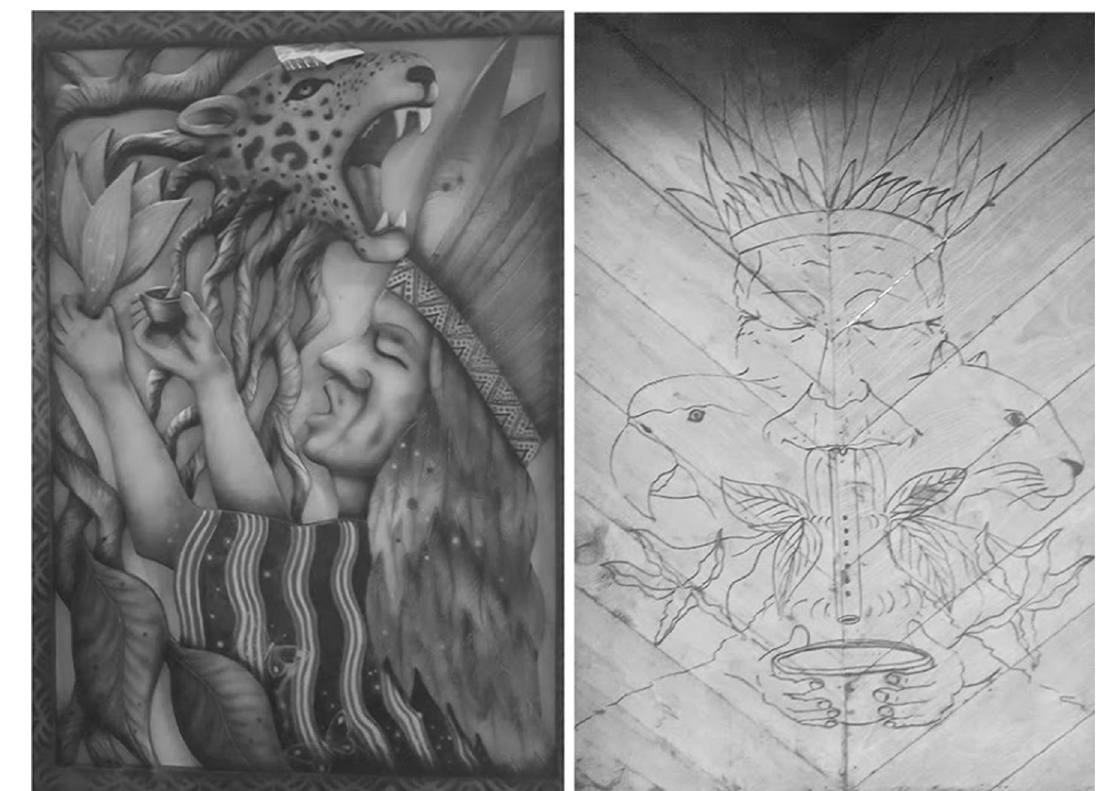
Fig. 2 Pictures of Shaman in ayahuasca ritual referring to leaves of P. viridis and lianas of B. caapi in a vase containing ayahuasca bev- erage, often accompanied by singing, culminating in the vision of a jaguar or birds. Left: Picture at Ambiaku Turistic Center, Municipal-